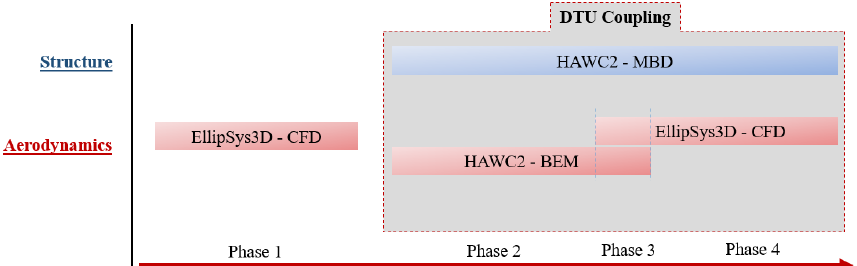
Figure 3. Process diagram of conducted simulations.